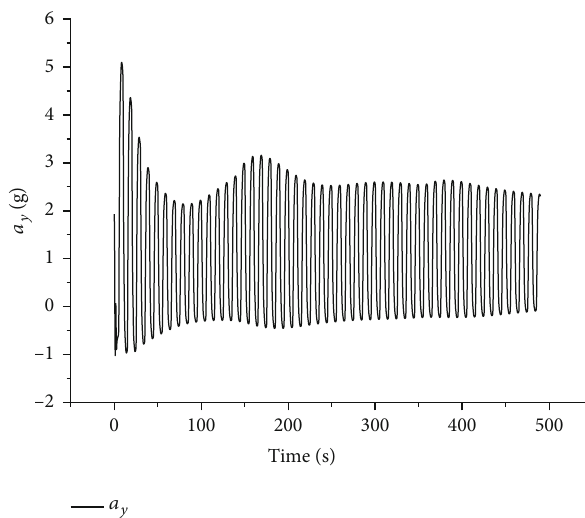
Figure 24: Normal acceleration with attitude control.